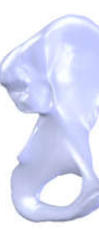
Figure 26. Final model of the sacrum in SolidWorks.